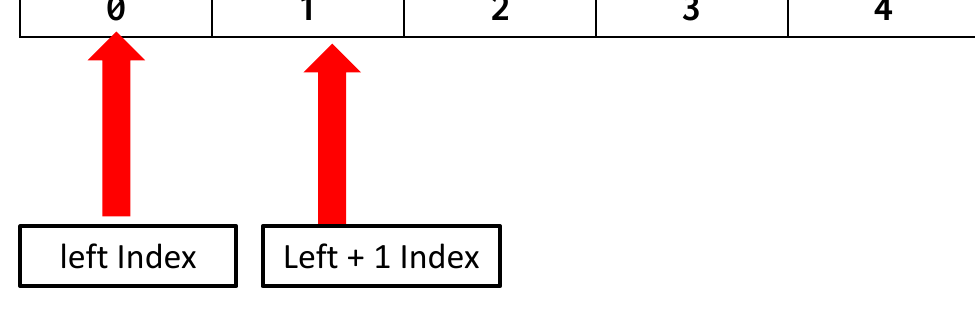
Figure 2. State space representation. Table 1. State space